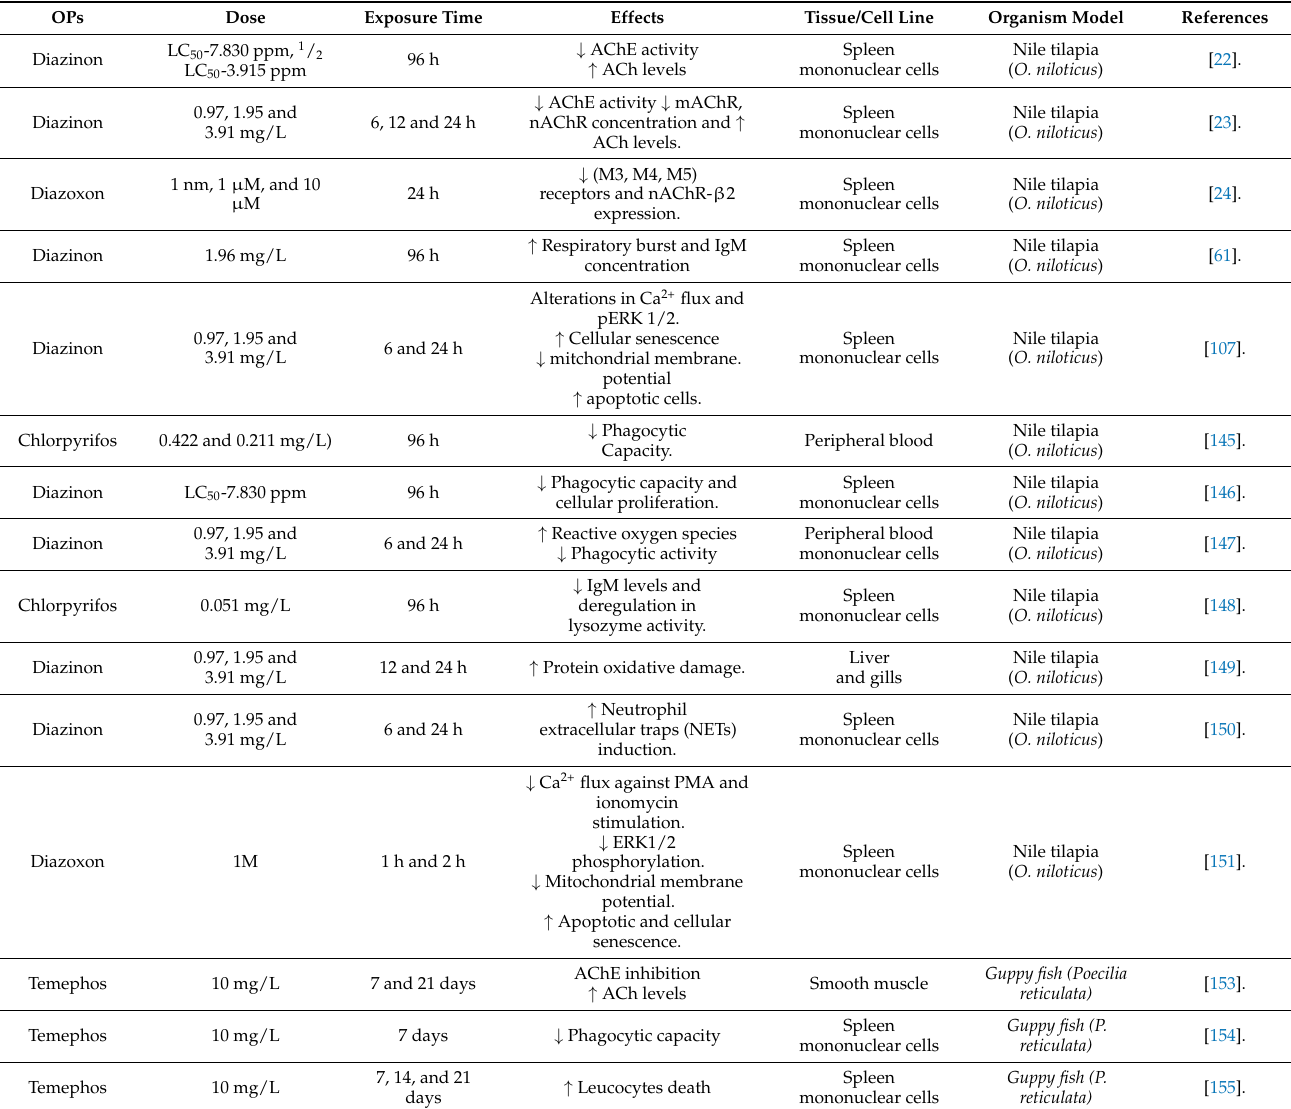
Table 3. Effect of OPs on the molecular and cellular parameters of fishes leukocytes as a study